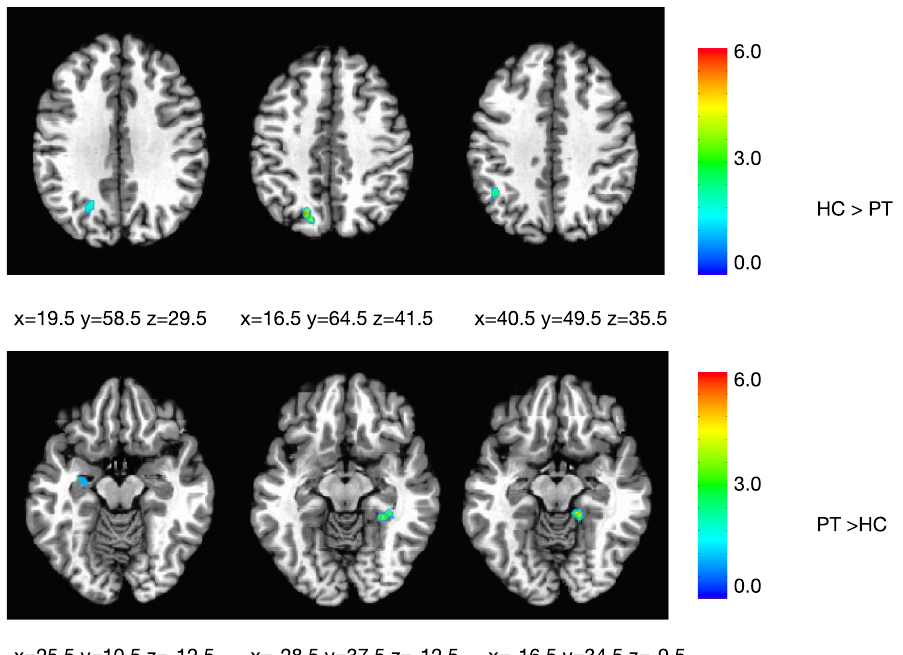
Figure 1. SMA connectivity at rest. ( A ) Left intraparietal sulcus and precuneus in patients were lower compared to HC. ( B ) Left hippocampus, right parahippocampal cortex and right fusiform gyrus in patients were higher compared to